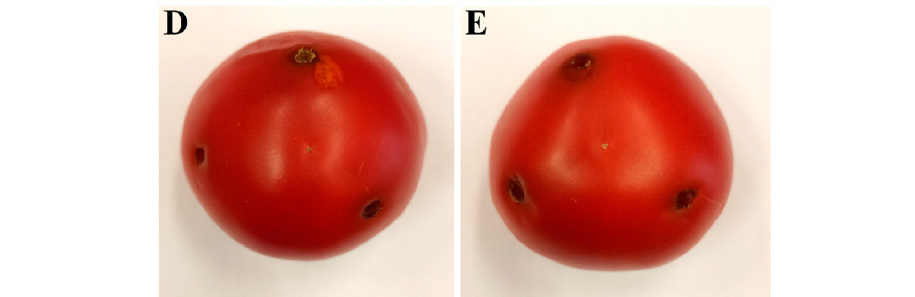
Figure 5. Biocontrol of A. flavus by yeasts A. pullulans PP4 and A. pullulans ZD1 in tomato fruit after 7 days of incubation at 21–22 ◦ C. ( A )—tomato inoculated with A. pullulans PP4 and sterile distilled water; ( B )—tomato inoculated with A. pullulans ZD1 and sterile distilled water; ( C )—tomato inoculated with A. flavus and sterile distilled water; ( D )—tomato inoculated with A. flavus and A. pullulans PP4; and ( E )—tomato inoculated with A. flavus and A. pullulans